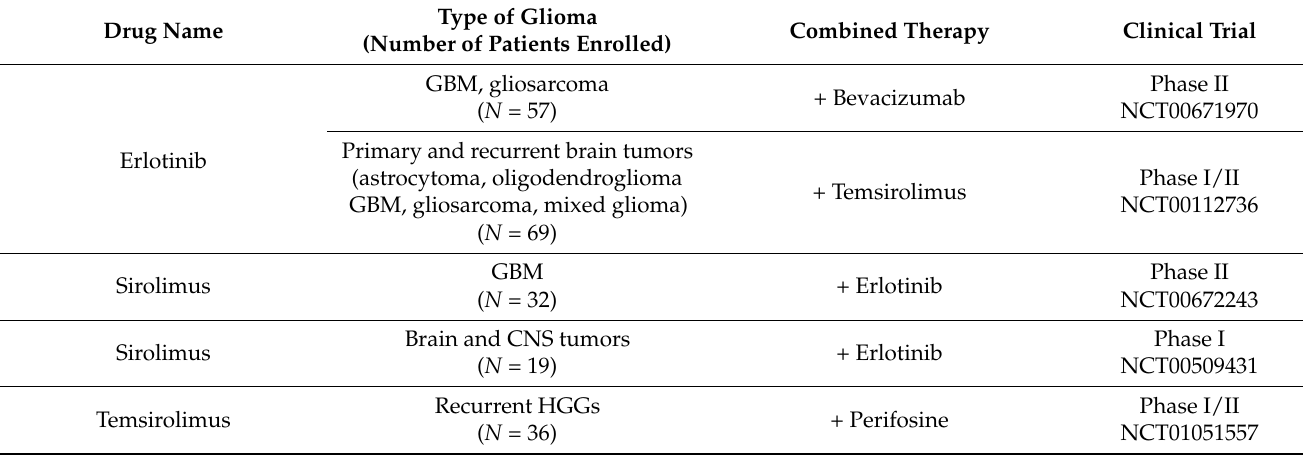
Table 4. Ongoing clinical trials on adult gliomas based on a combined approach targeting RTKs/mTOR/PI3K axis (data from http://clinicaltrials.gov, accessed on 30 April